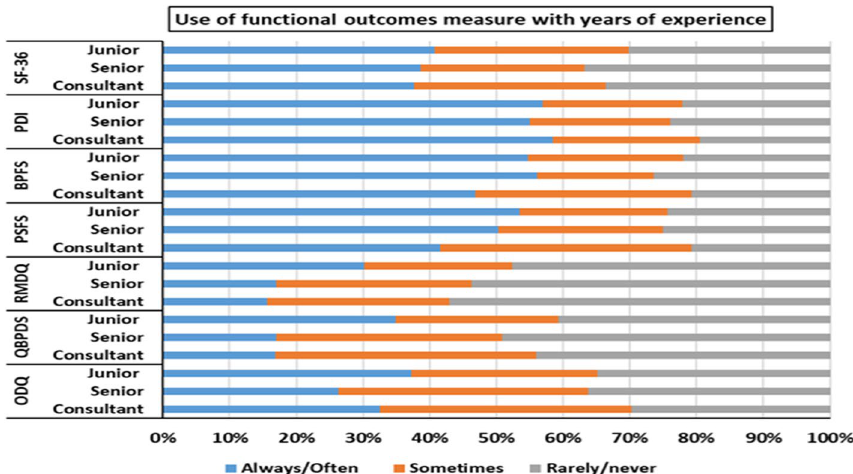
Fig. 2 The use of functional outcome measure with physical therapist years of